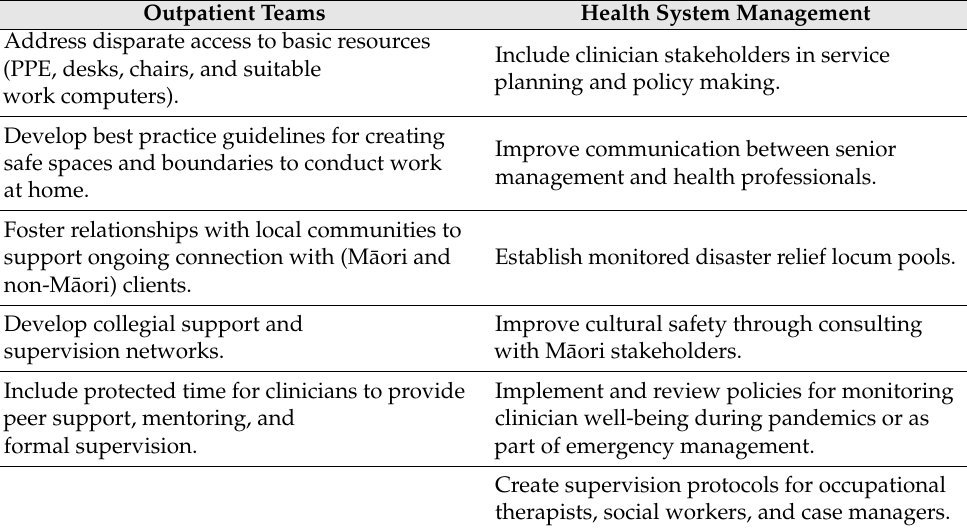
Table 2. Recommendations for outpatient teams and health system